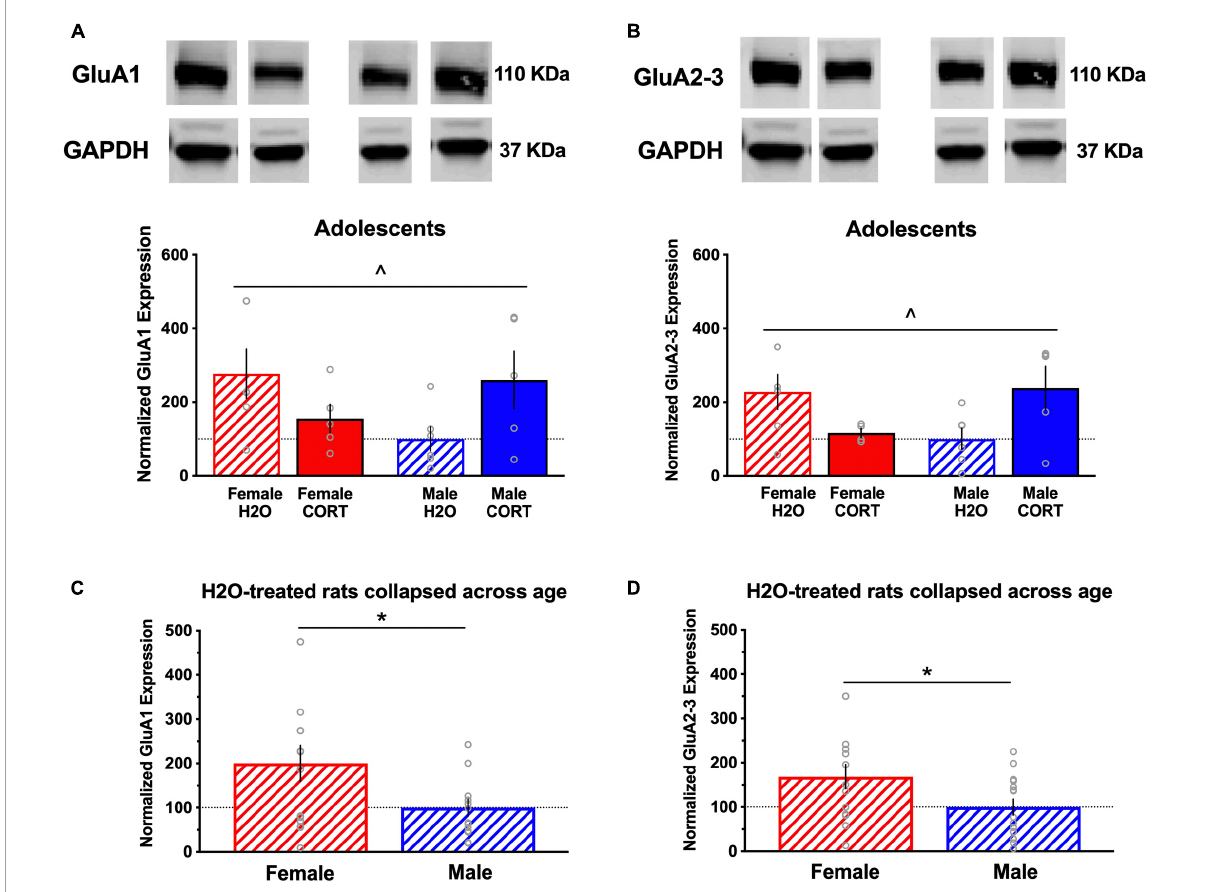
FIGURE7 Glutamate receptor subunit expression is altered as a function of sex and adolescent CORT treatment. Representative blots for each treatment group are shown, and a full, uncropped blot can be found in Supplementary Figure S1 . Significant sex × treatment interactions were found for expression of the AMPA receptor subunits GluA1 (A) and GluA2/3 (B) in the BLA of adolescent-exposed rats, with decreased and increased expression in CORT-treated females and males, respectively, relative to their controls. Significant overall sex differences in H 2 O-treated rats were found in BLA levels of GluA1 (C) and GluA2-3 (D) , indicating significantly increased basal expression in these AMPA receptor subtypes in females compared to males. ˆ p < 0.05 sex × treatment interaction; * p < 0.05 (male vs. female).